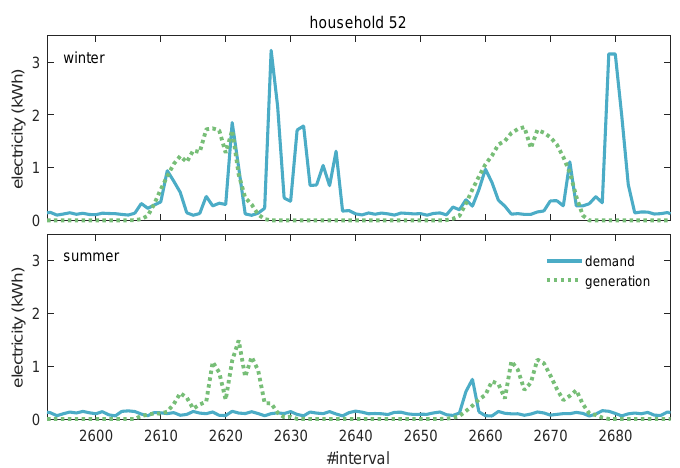
Figure 9. Demand and generation for two seasons. The demand and PV generation of Household 52 for two consecutive representative days of winter 2010 and summer 2010 are